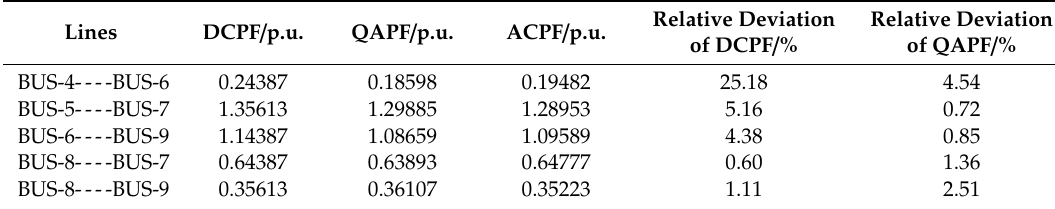
Table 3. Results by di ff erent power flow models.